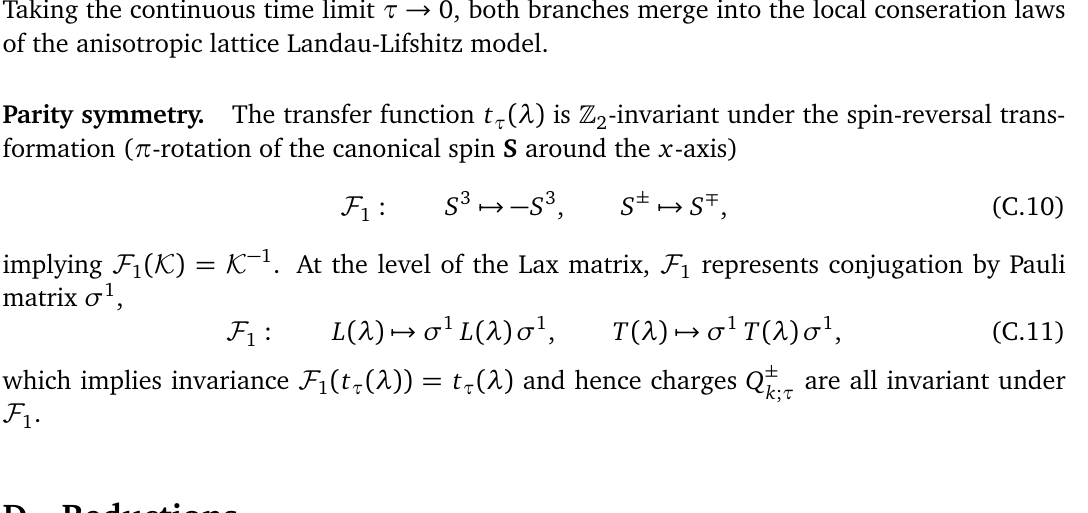
Figure 10: Reductions of the anisotropic discrete-time propagator Φ τ corner), obtained via taking various combinations of (cid:37) , ∆ , τ → 0 limits. The com- plete reduction obtained by taking all three limit yields the isotropic Landau-Lifshitz field theory H (lower-right LL